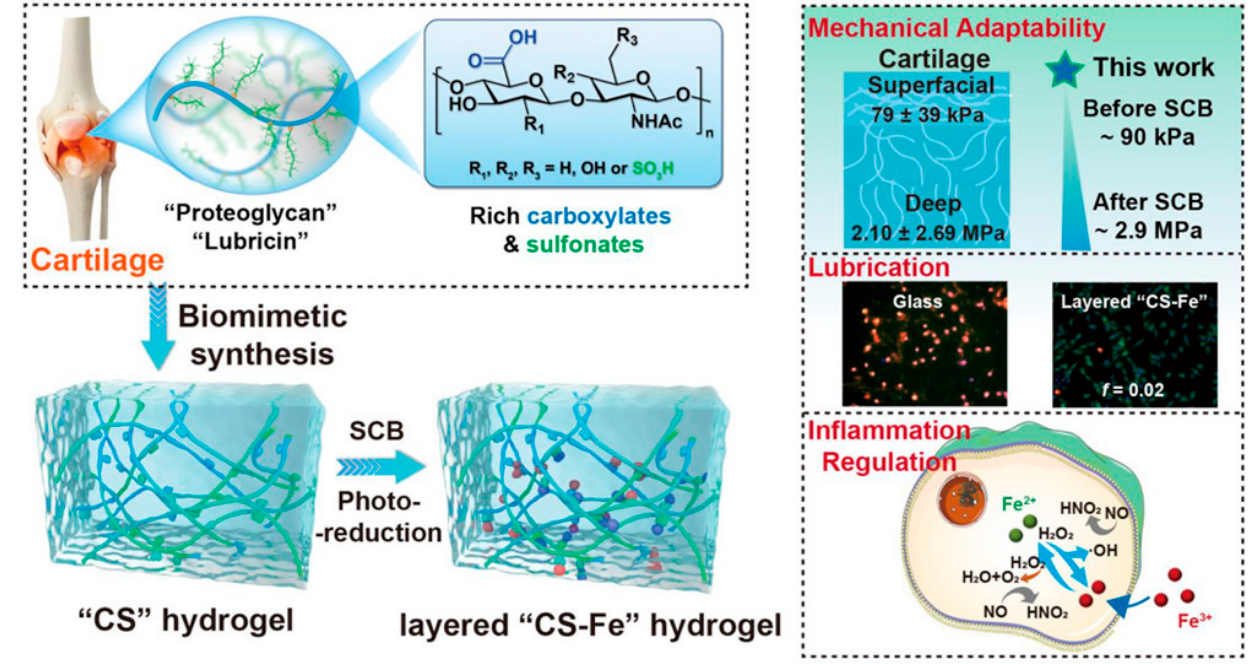
Figure 6. Preparation of cartilage components (proteoglycans and lubricin) and layer structure-inspired “CS” and layer “CS-Fe” hydrogels and their main functions, including mechanical adaptabil- ity, low friction, and inflammation regulation. Reprinted with permission from Ref [71]. Copyright 2022, American Chemical Society.